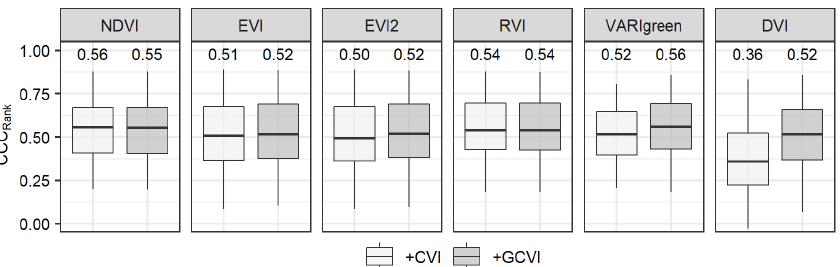
Figure A1. The concordance correlation coefficients of ranks for models with two vegetation indices in the pre-peak stage. Values show the median CCC Rank . For better visualisation, the figure excludes negative CCC Rank.